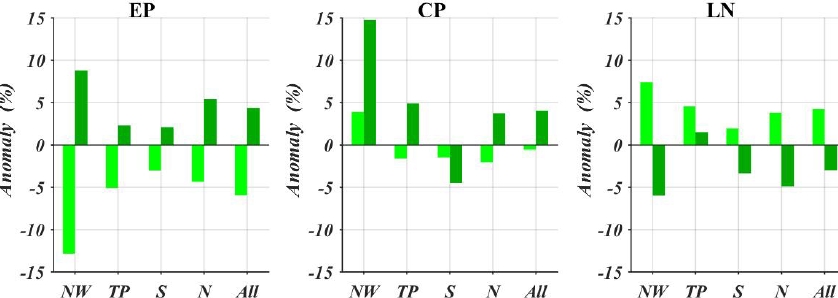
Figure 3. Average annual precipitation anomaly by subregion during EP, CP, and LN phases. Light green represents developing years, and dark green represents decaying years.